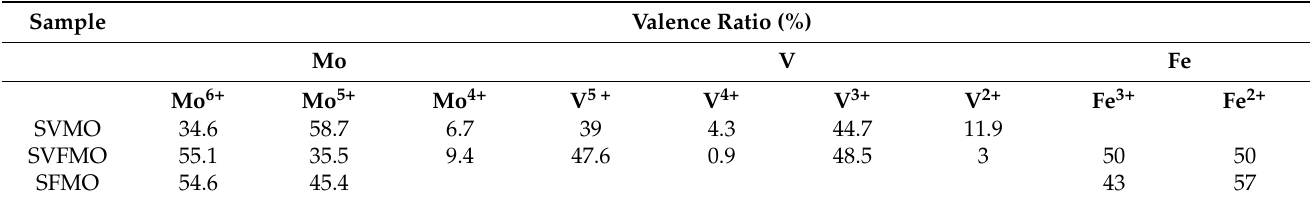
Table 1. Comparison of the calculated Mo, V and Fe elements valence ratio in SVMO, SVFMO and